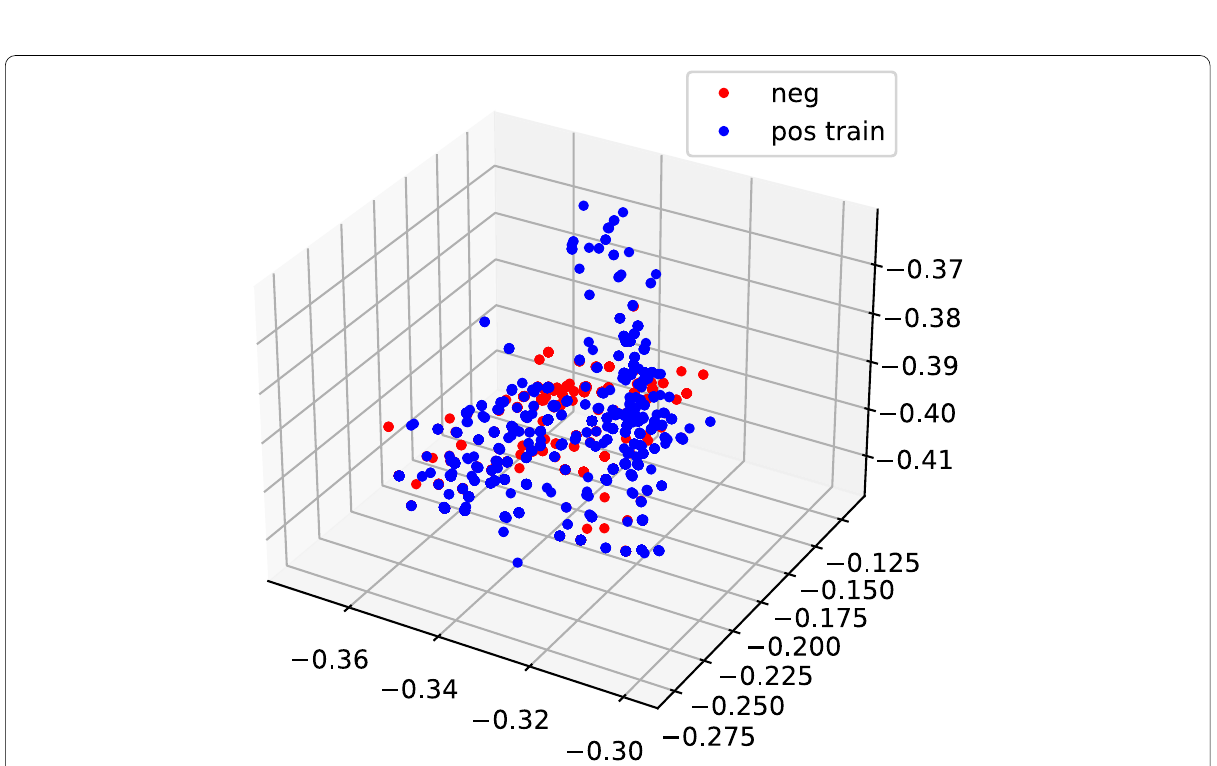
Fig. 10 Sample low-dimensional information of the model with memory